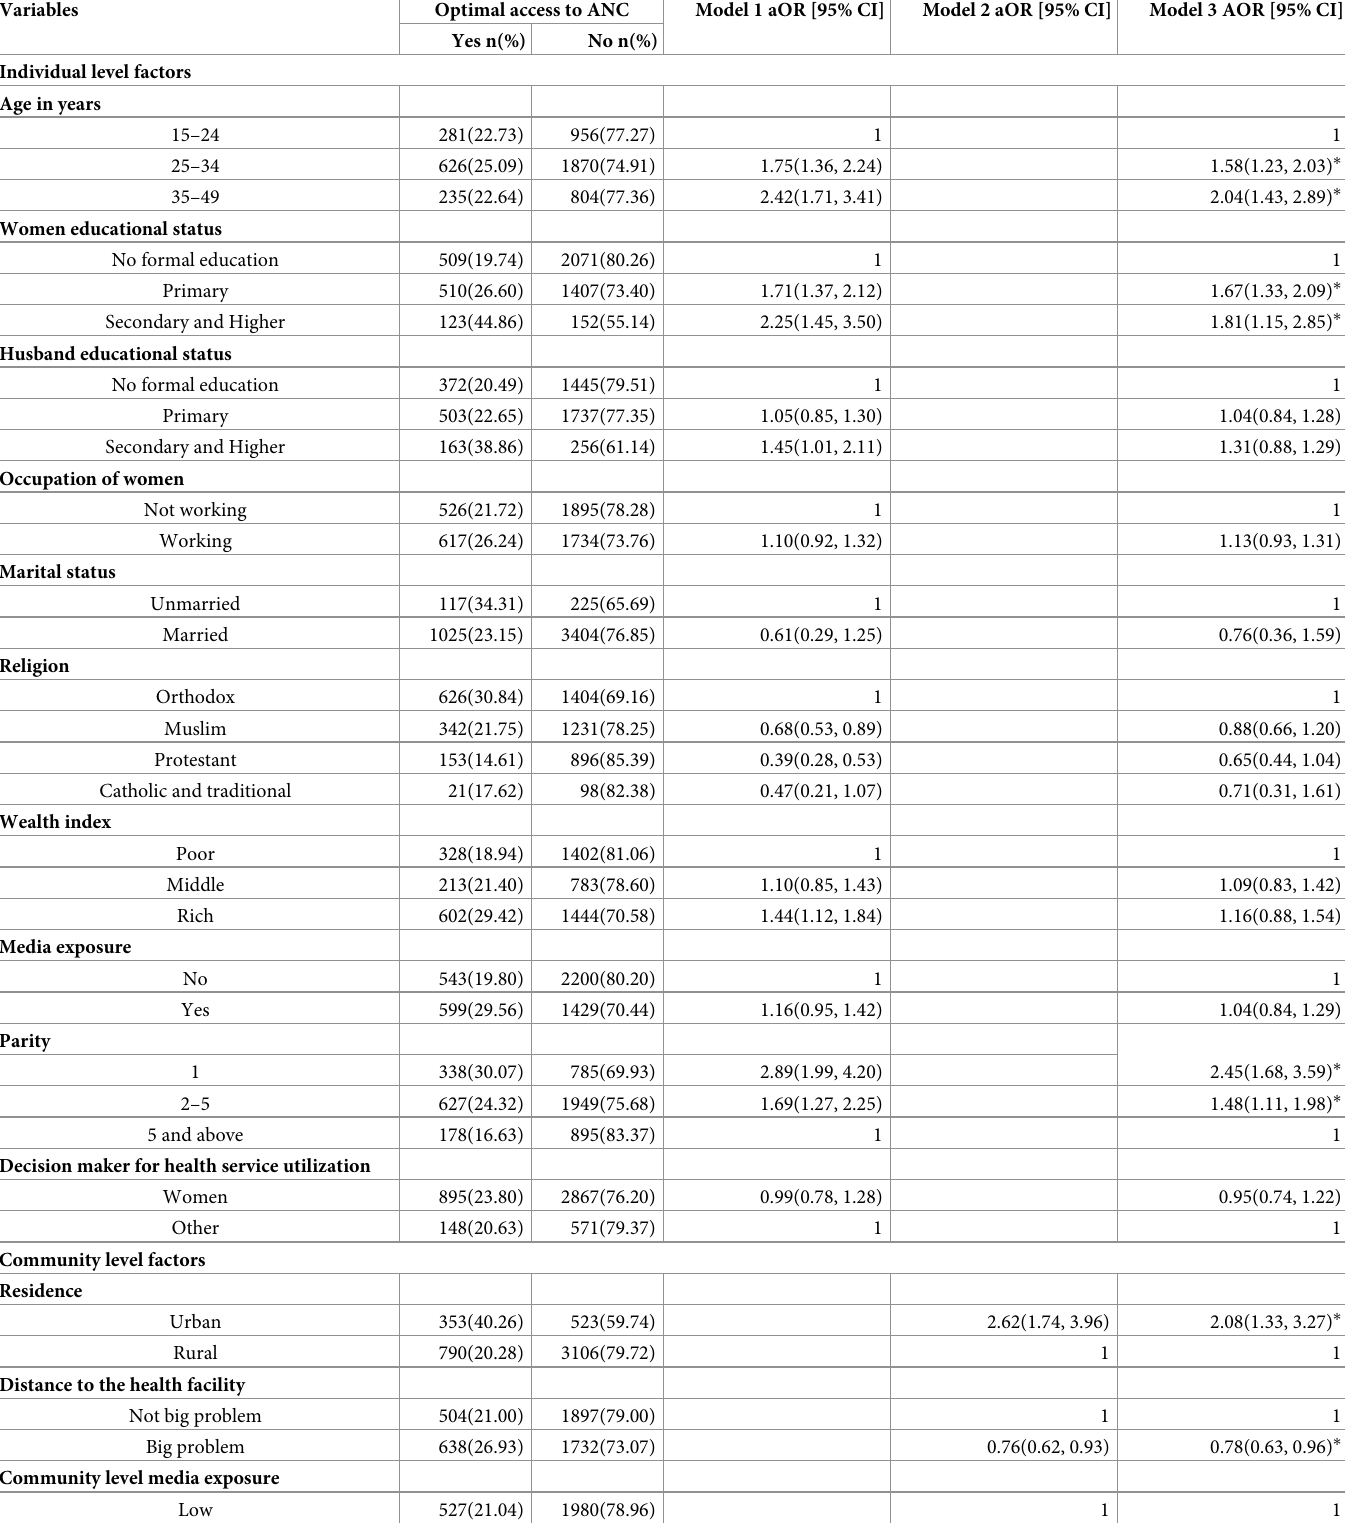
Table 2. Multilevel analysis of factors associated with optimal ANC access in Ethiopia, 2016 (n =